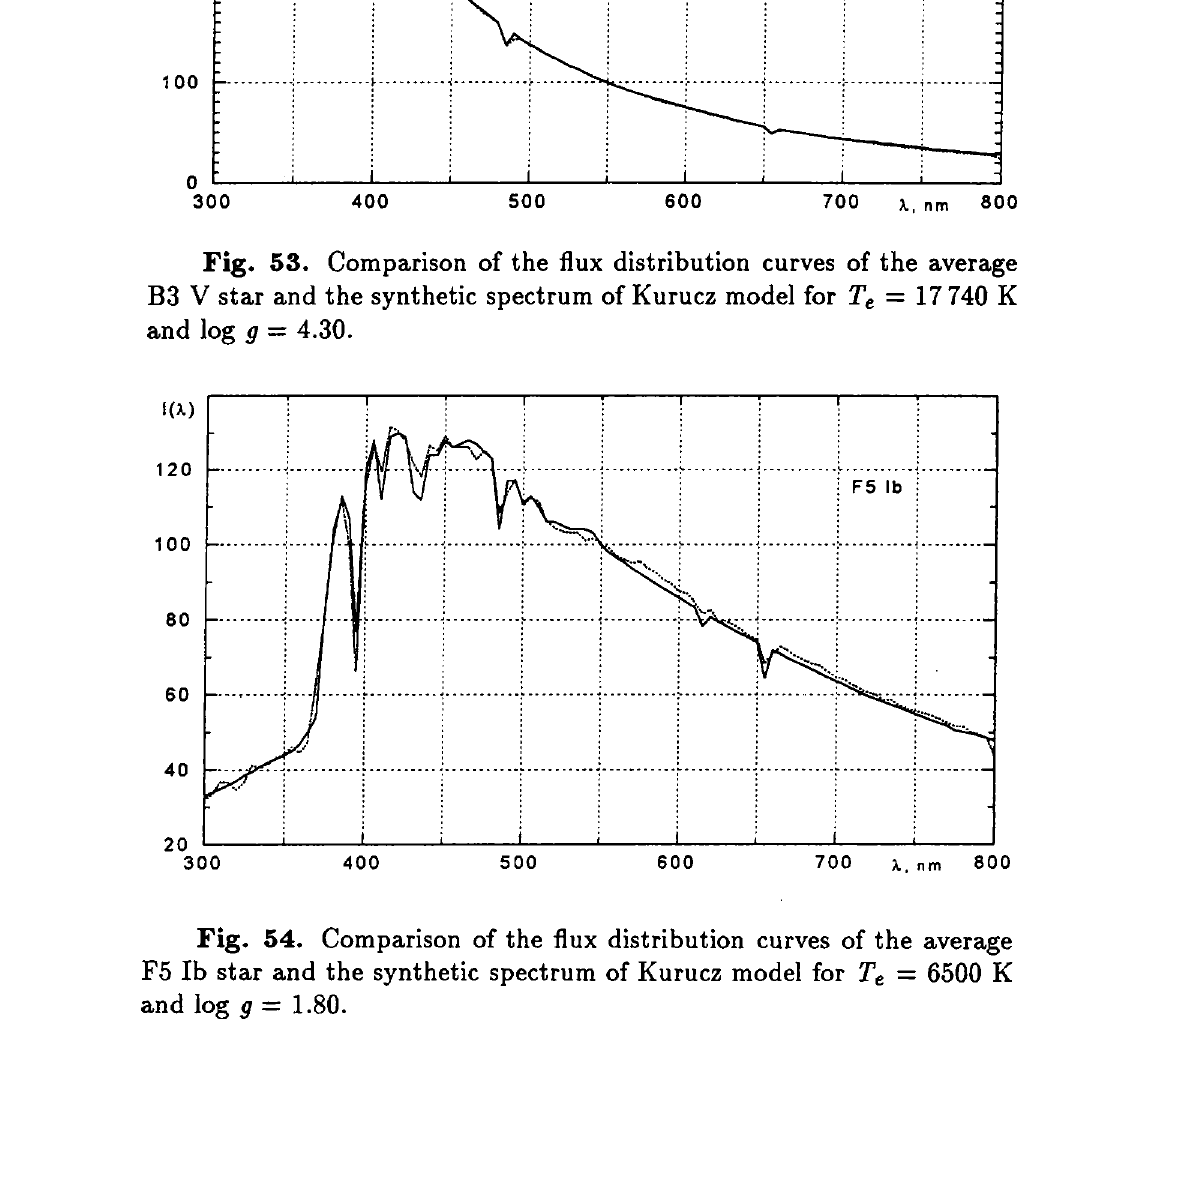
Fig. 54. Comparison of the flux distribution curves of the average F5 lb star and the synthetic spectrum of Kurucz model for T and log g =